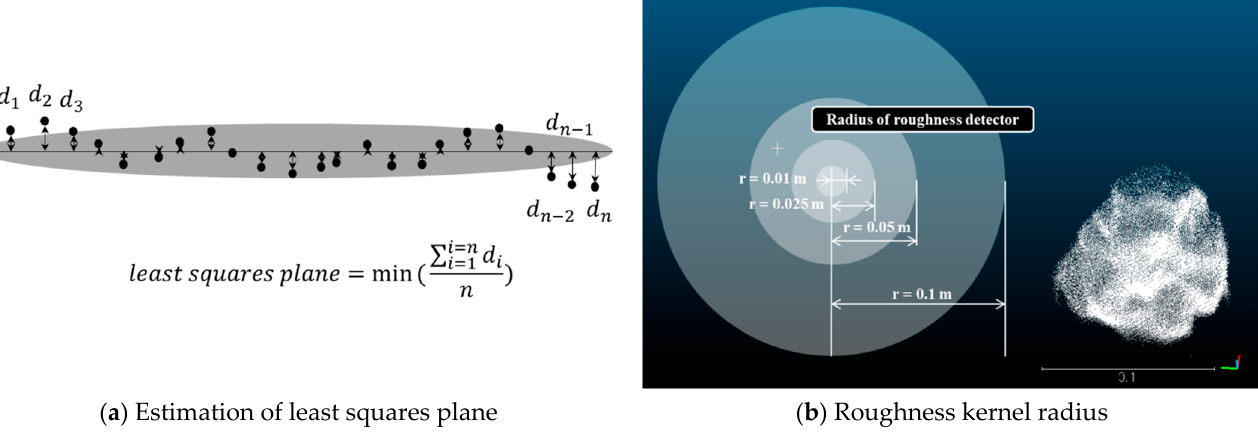
Figure 10. Estimation of roughness kernel.